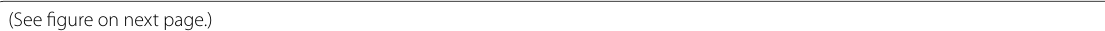
, Utsu u ) for target